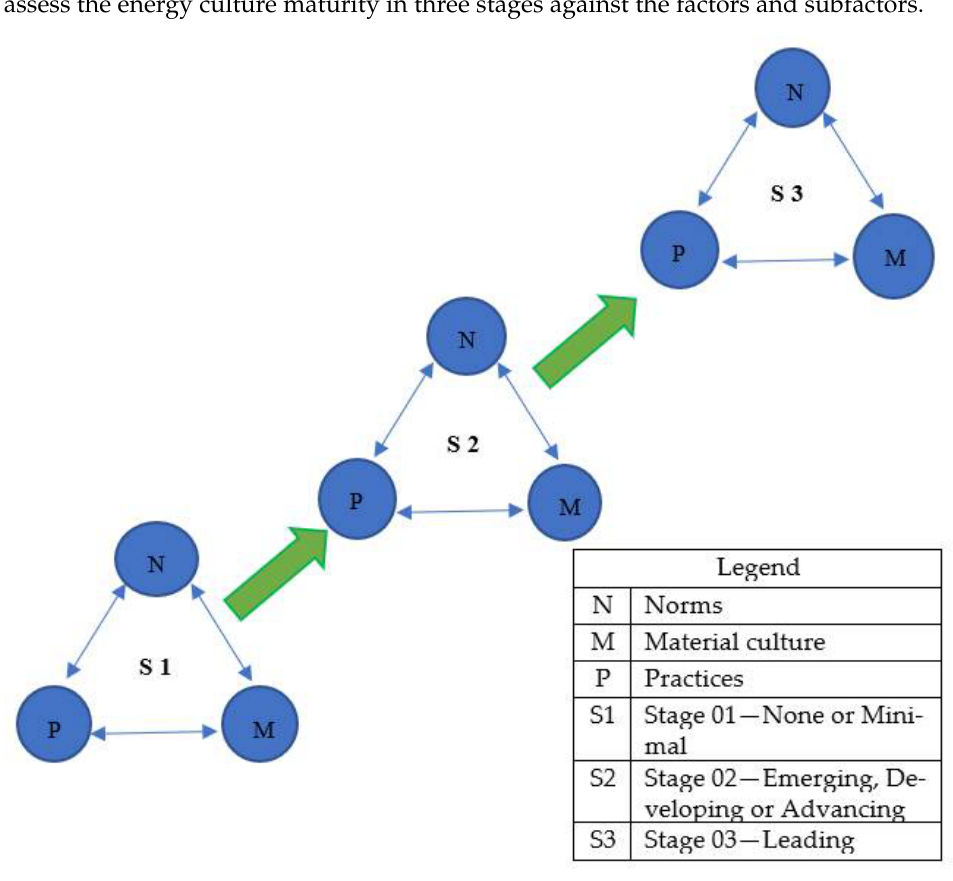
Figure 7. Energy culture maturity conceptual framework (Source: Author developed based on energy cultures framework [43] and Finnerty et al. [56]).